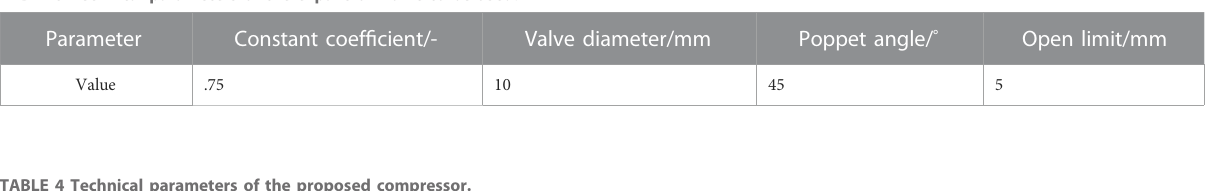
TABLE 3 Technical parameters of the expansion valve to be used.